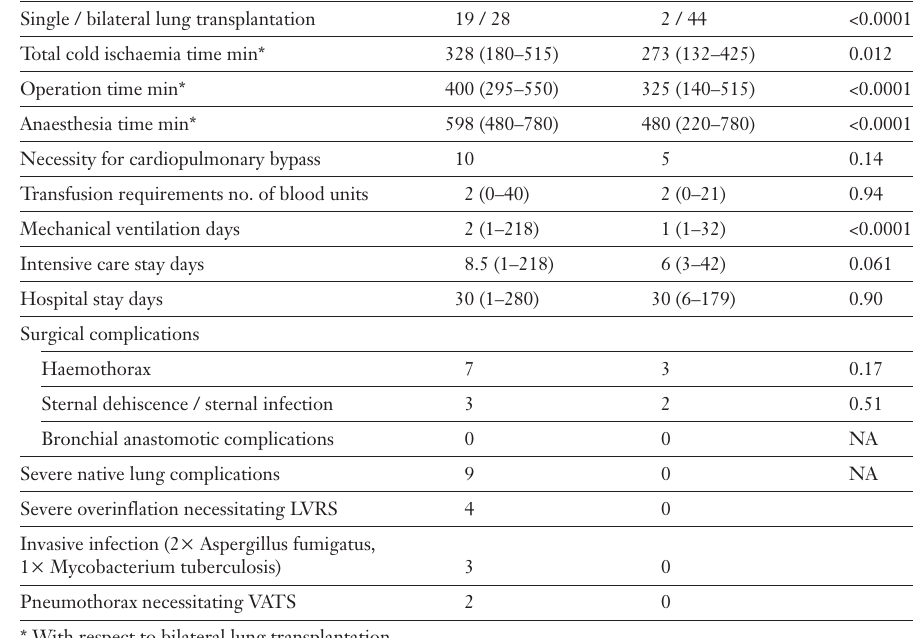
Figure 1 Kaplan-Meyer esti- mates of survival after lung trans- plantation. The difference between the early and the recent period was calculated by the log-rank